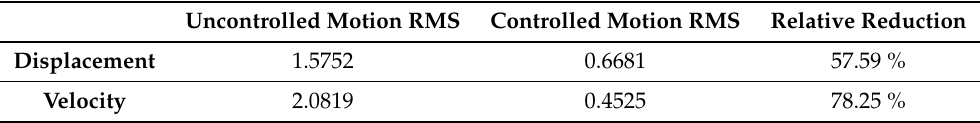
Table 2. Performance of the Optimal Feedforward